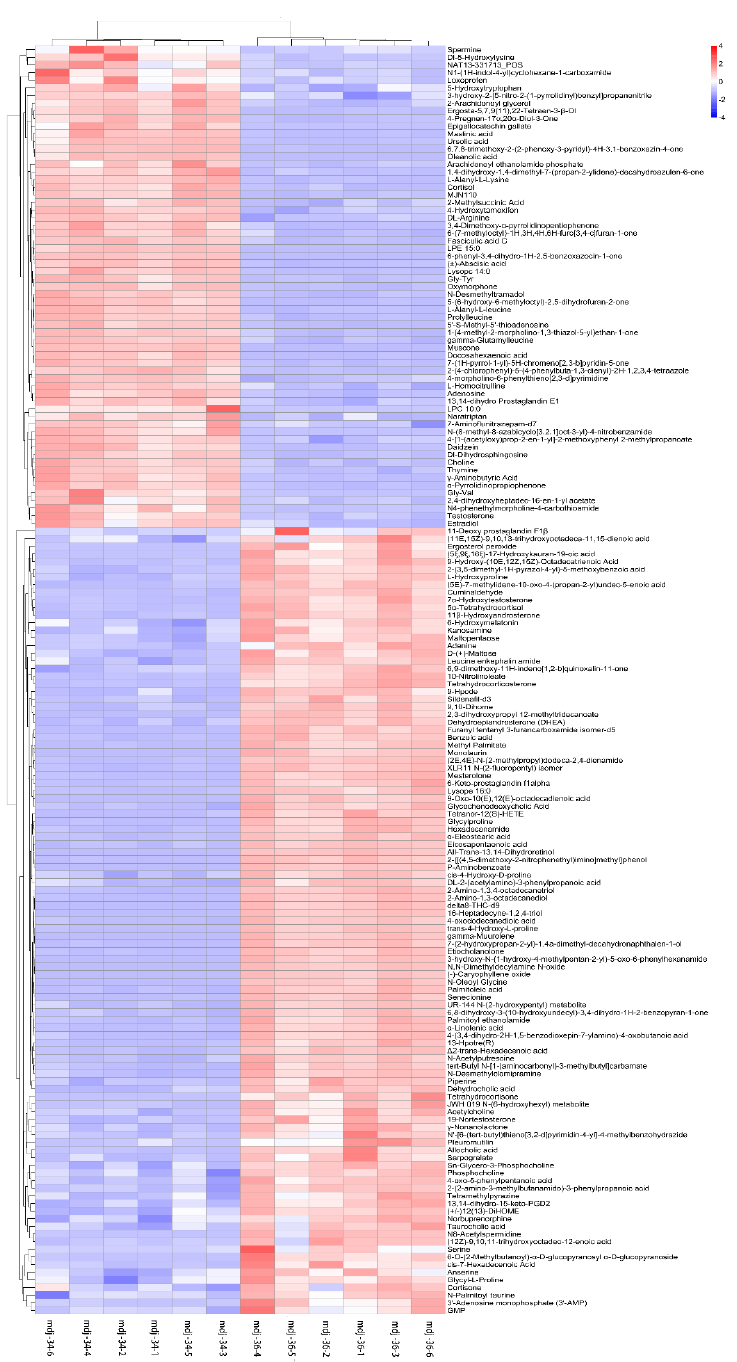
Figure 4. Heatmap analysis of the differentially expressed metabolites (DEMs) in the B. velezensis mdj-36 and mdj-34 growth media. The tree indicates the similarity of metabolites, and the color corresponds to the amount of each metabolite. Each column represents one sample.